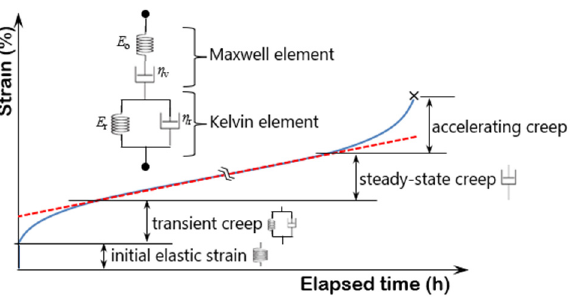
Figure 1. Typical creep behavior of a viscoelastic material and Burgers